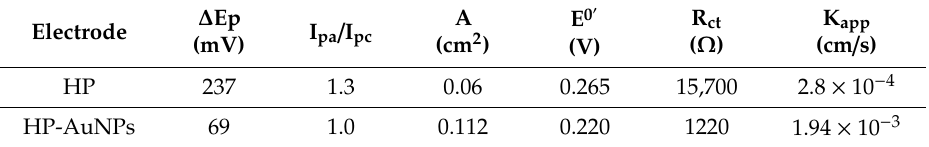
Table 1. The electrochemical parameters of flexible screen-printed electrodes, HP and HP-AuNPs. ∆ Ep Electrode I pa / I (mV)